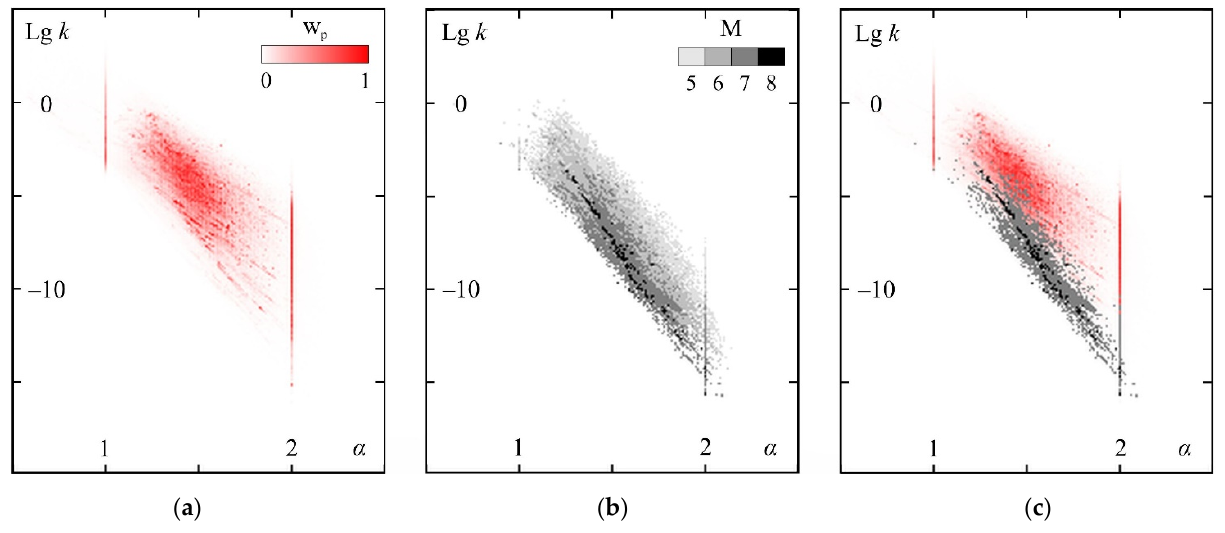
Figure A1. ( a ) Distribution of the specific weight of predictability w p for activating the seismic en- ergy flux, ( b ) foreshock predictability of strong earthquakes and ( c ) their combination in the coor- dinates of the α –lg k parameters of the DSDNP equation, according to Reference [24]. M is the mag- nitude of predicted strong